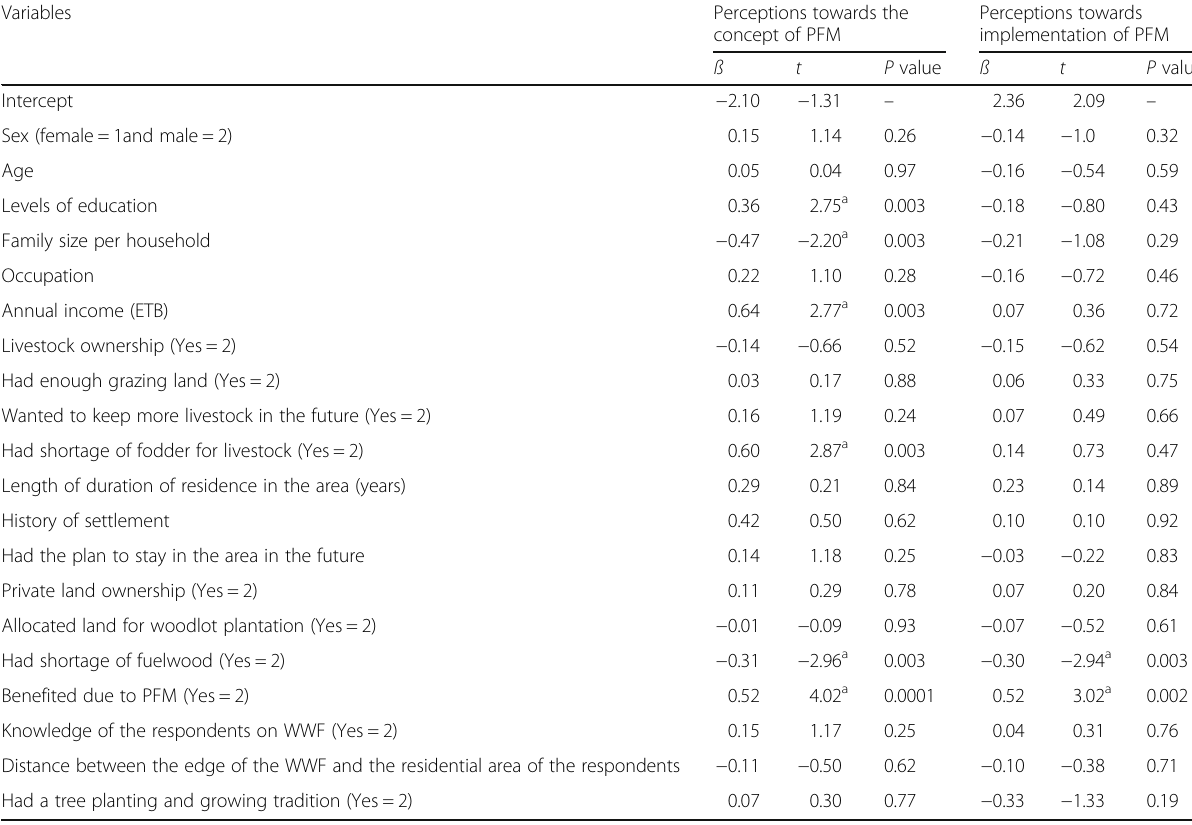
Table 3 Multiple linear regression model (standardized coefficients were reported) to predict the perceptions of local people towards the concept of PFM ( R 2 = 0.52 (Adj. R 2 = 0.30), df = 19; F = 2.362, overall P = 0.009), and implementation of PFM ( R 2 = 0.39 (Adj. R 2 = 0.11), df = 19; F = 1.385, overall P = 0.043) in WWF (+ = a positive change in perceptions and − = a negative change in